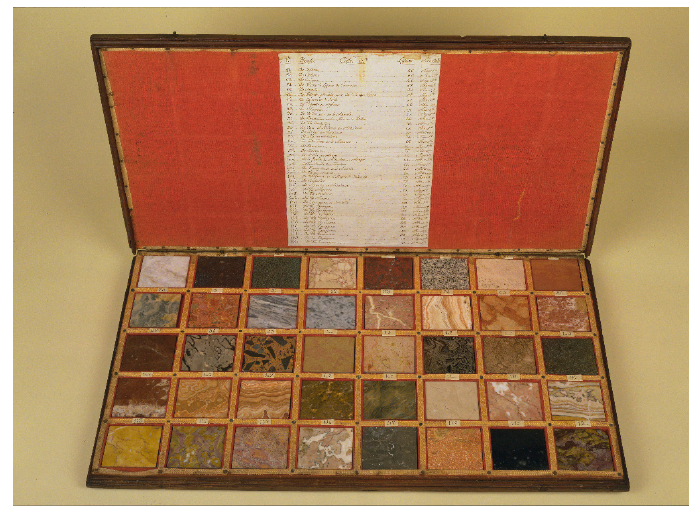
Figure 1. Showcase of marbles from the Spanish Royal Palace, Box number 3, inventory number 1013958. Copyright © Patrimonio Nacional.